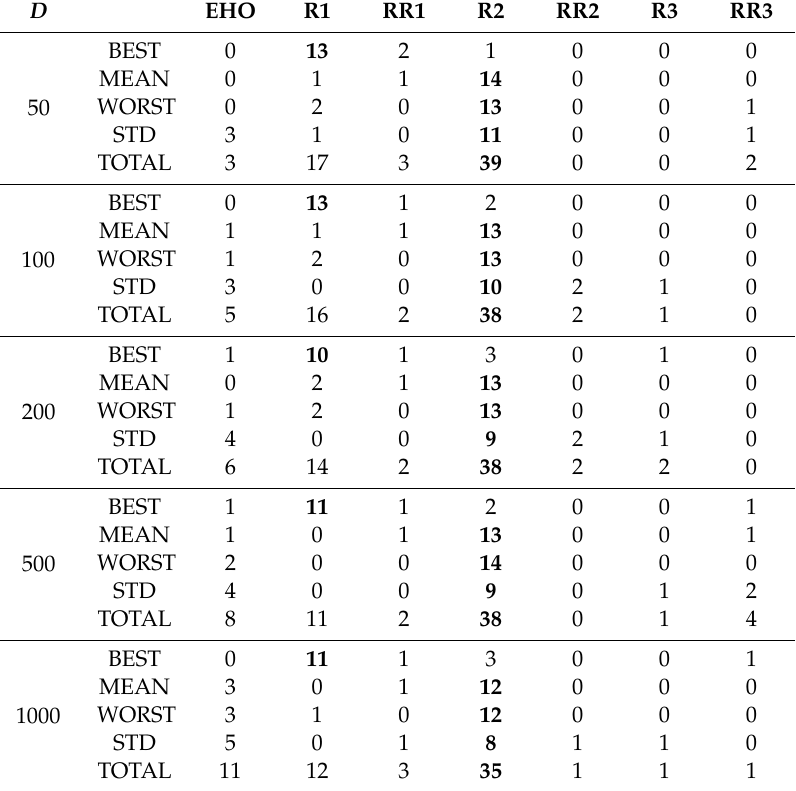
Table 12. Optimization results values obtained by EHO and six improved methods for 16 benchmark functions.